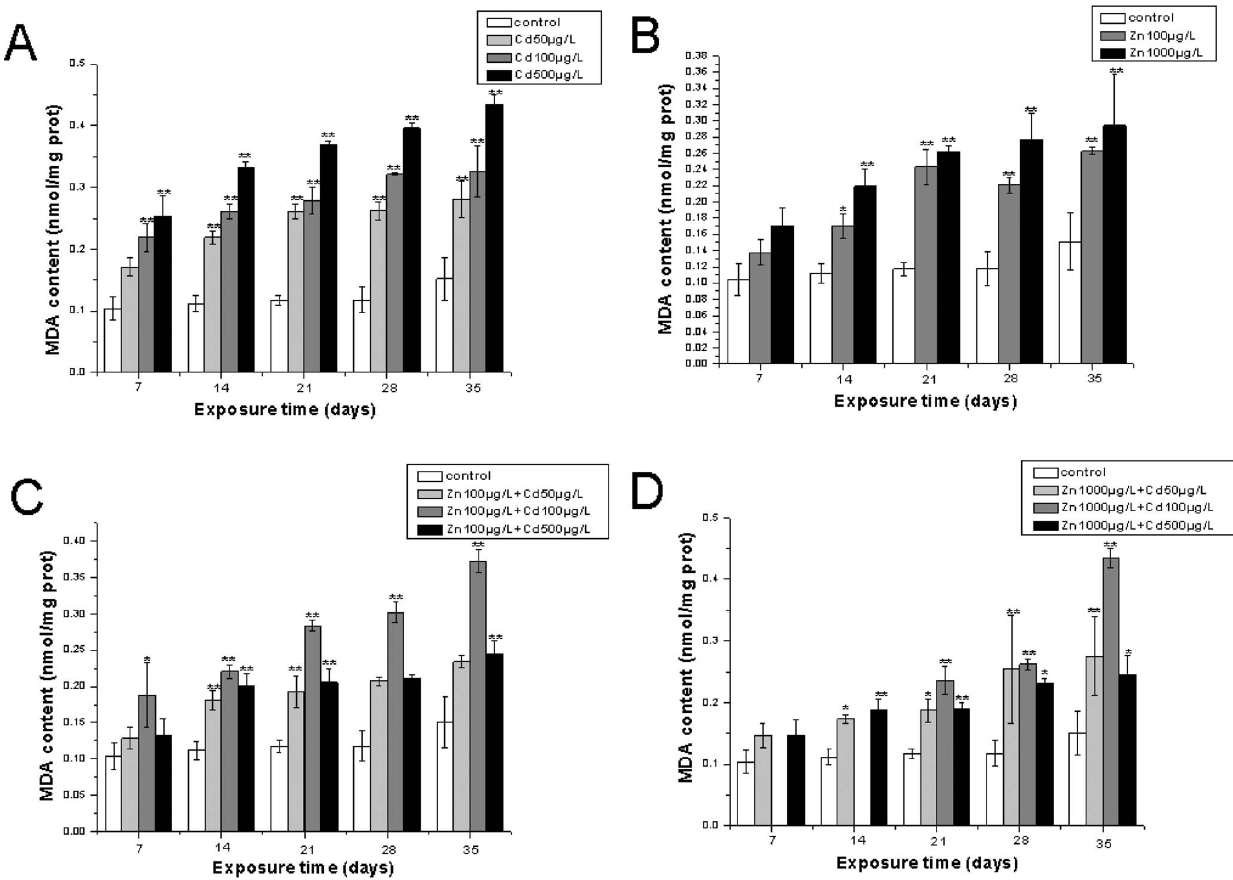
Figure 1. The MDA contents in the gills of S.henanense exposed to Cd and Zn either as a separate treatment or both metals combined for 7, 14, 21, 28, 35days. Data were expressed as mean values 6 standard error. Statistical significances were analyzed using one-way ANOVA compared to the control, *P , 0.05, **P , 0.01.